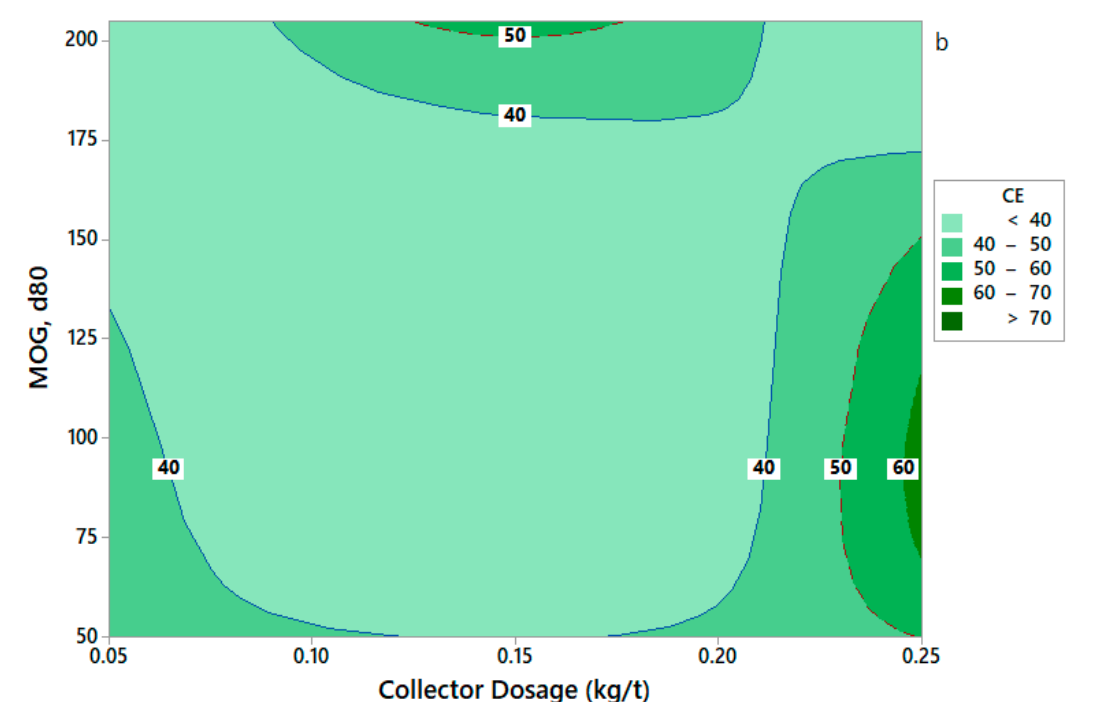
Figure 7. ( a ) Effect of depressant dosage and D80 on concentration efficiency. ( b ) Effect of D80 and collector dosages on concentration efficiency.